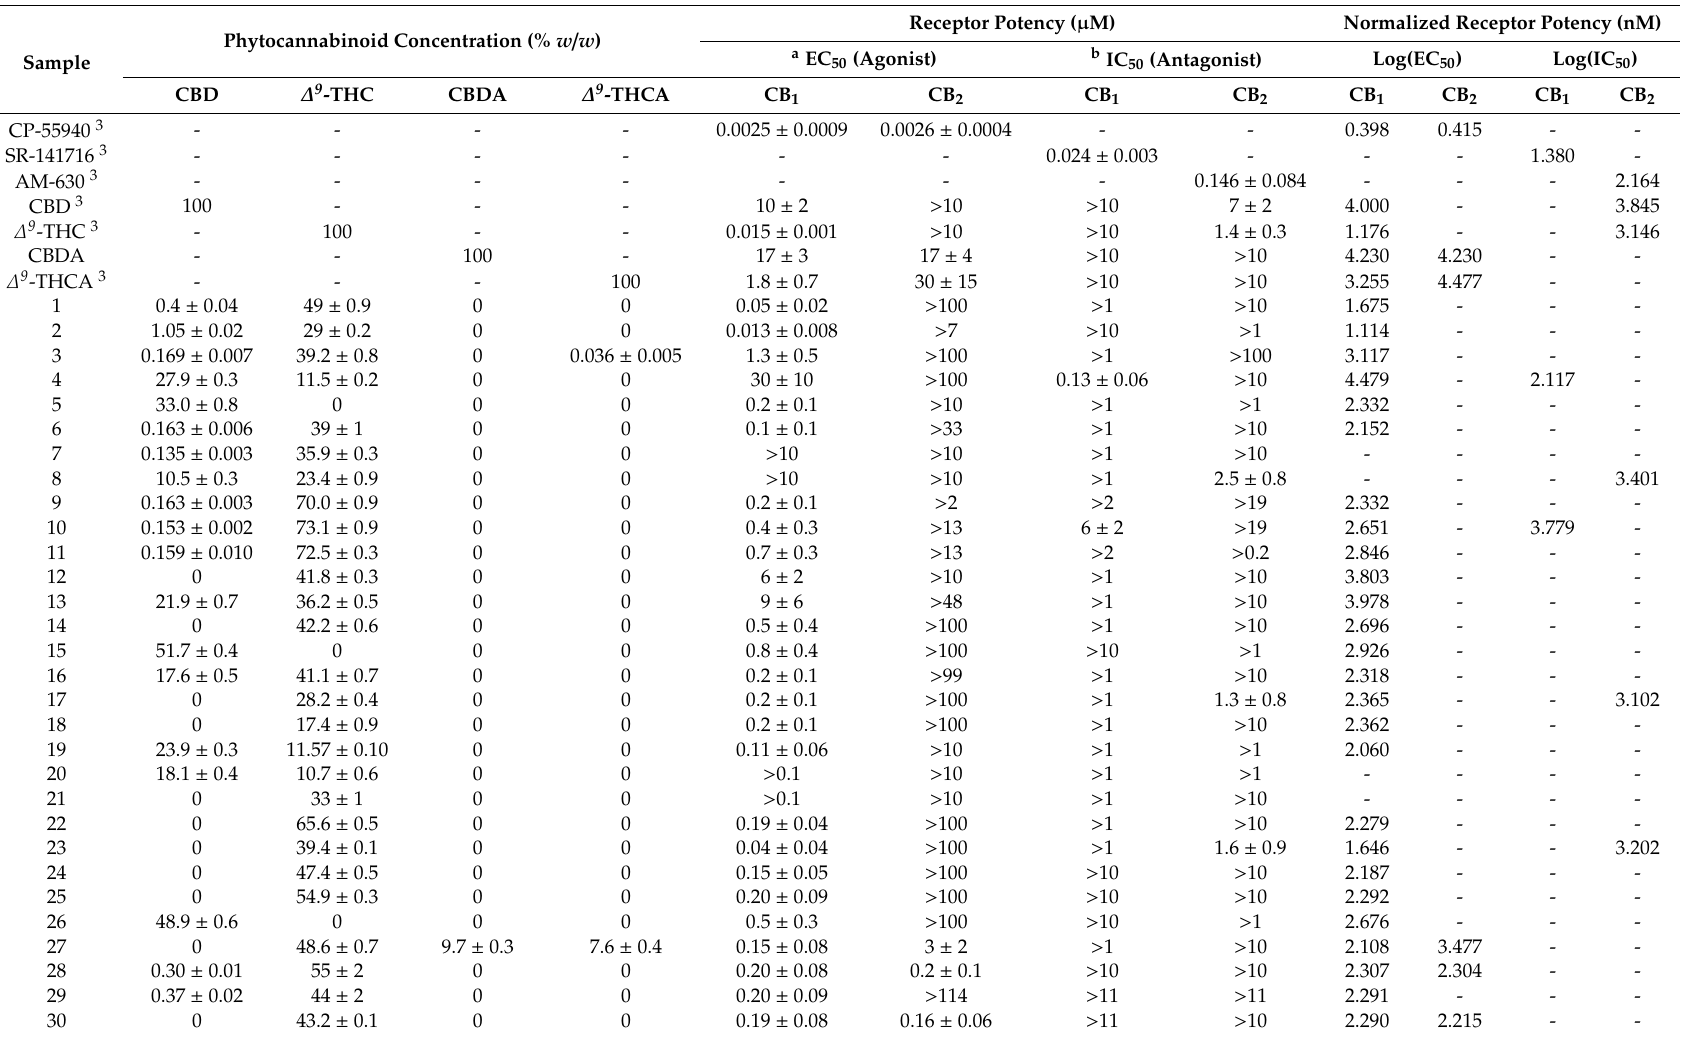
Table 1. Phytocannabinoid concentrations and corresponding receptor potencies of cannabis extracts, as well as pure phytocannabinoids and reference compounds.